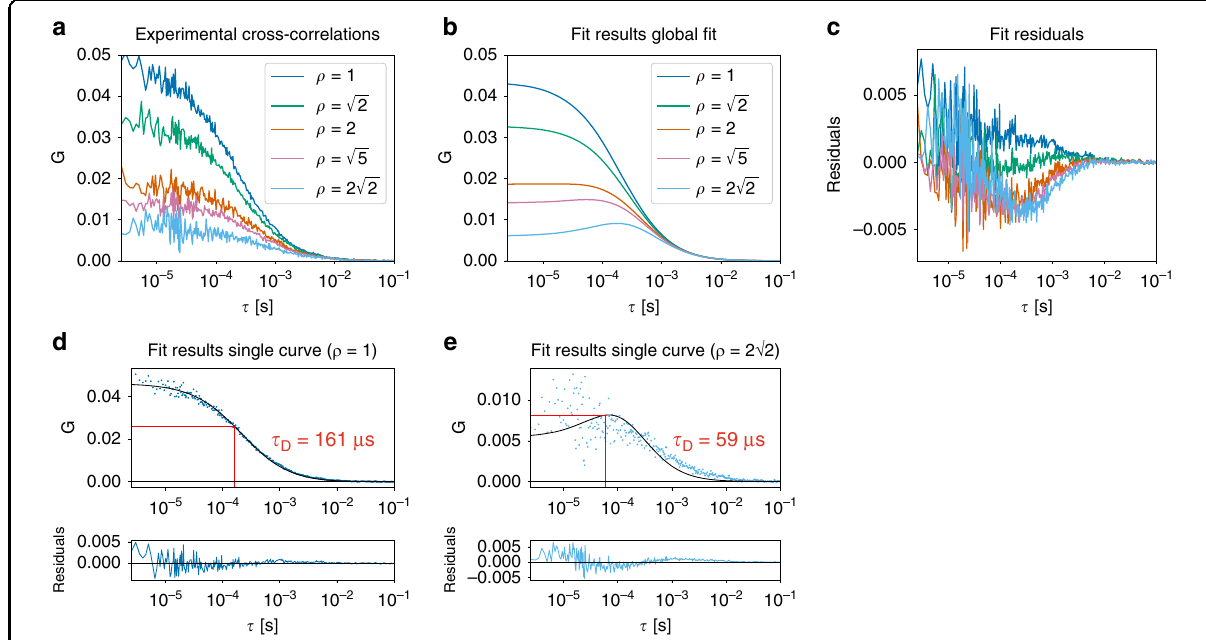
Fig. 4 Pair-correlation analysis on the Alexa 488 sample. a Experimental cross-correlation functions between the central pixel and the other pixels, b global fi t, and c fi t residuals for one of the measurements. The fi t result ( N = 4) is D = (32.5 ± 0.6) µm 2 s − 1 . The PSF size was kept fi xed at ω 0 = 141 nm, i.e., the value that was found with the GFP reference sample. The parameter ρ represents the distance between the two pixels of which the signals are correlated: ρ = 1 corresponds to the distance between the central pixel and a laterally neighbouring pixel, ρ = distance between the central pixel and a diagonally neighbouring pixel, etc. A distance of ρ = 1 corresponds to a shift in the fi eld of view of 75 nm. For c , the same colour code was applied as for the other panels. d , e Experimental cross-correlation functions and individual fi ts for d ρ = 1 and ffiffiffi p e ρ = 2 2 . The τ D values in red represent the diffusion times obtained from the fi tted curves in